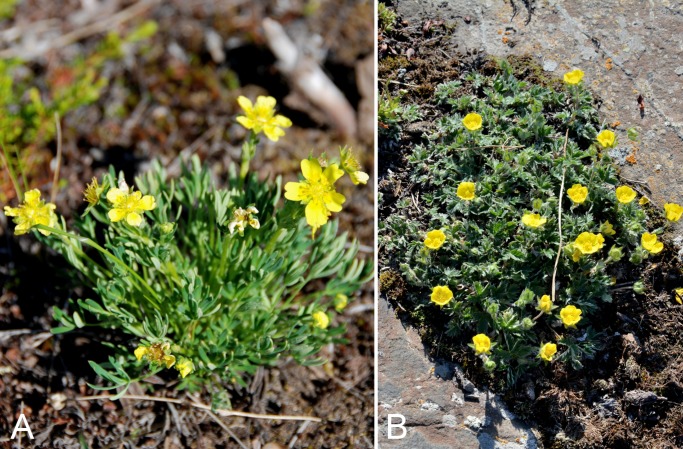
Potentilla biflora and Potentilla hyparctica.Potentilla biflora: (A) habit, Saarela et al. 3152. Potentilla hyparctica: (B) habit, Kugluktuk, Nunavut, 30 June 2014. Photographs by J. M. Saarela (A) and P. C. Sokoloff (B).